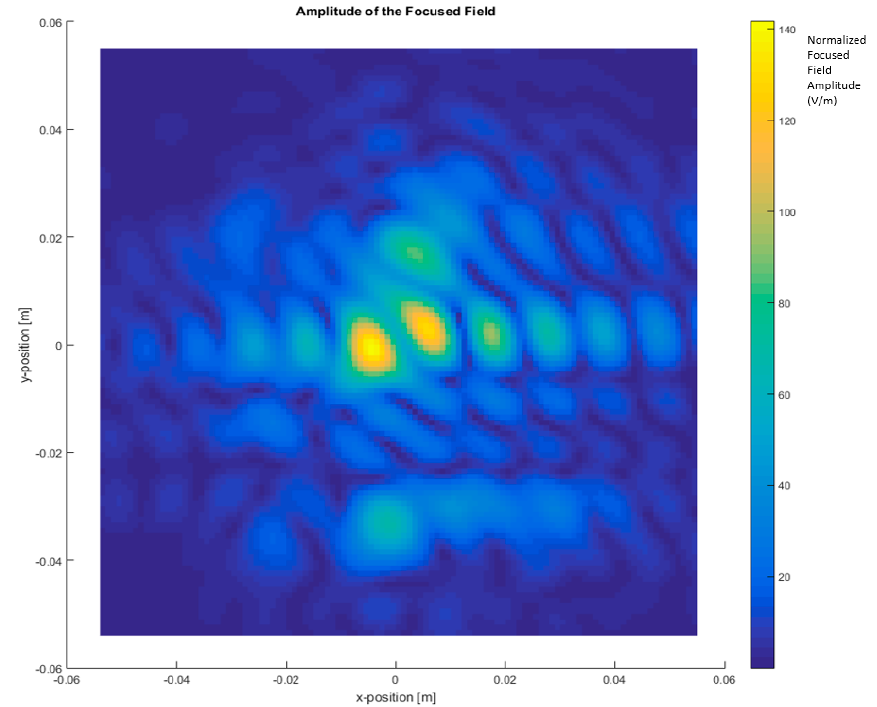
Figure 9. Di ff erential focused field amplitude between the metallic car with and without an antenna. Frequency range: 295 GHz to 305 GHz (BW = 10 GHz).